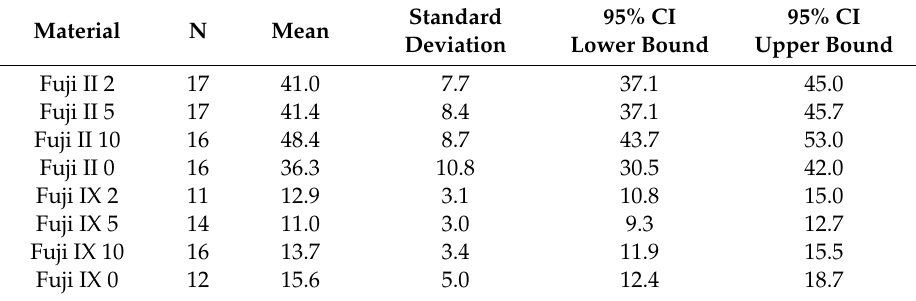
Table 3. Descriptive statistics for FS in MPa (sample size, mean value, standard deviation, lower and upper bounds for 95% confidence interval).